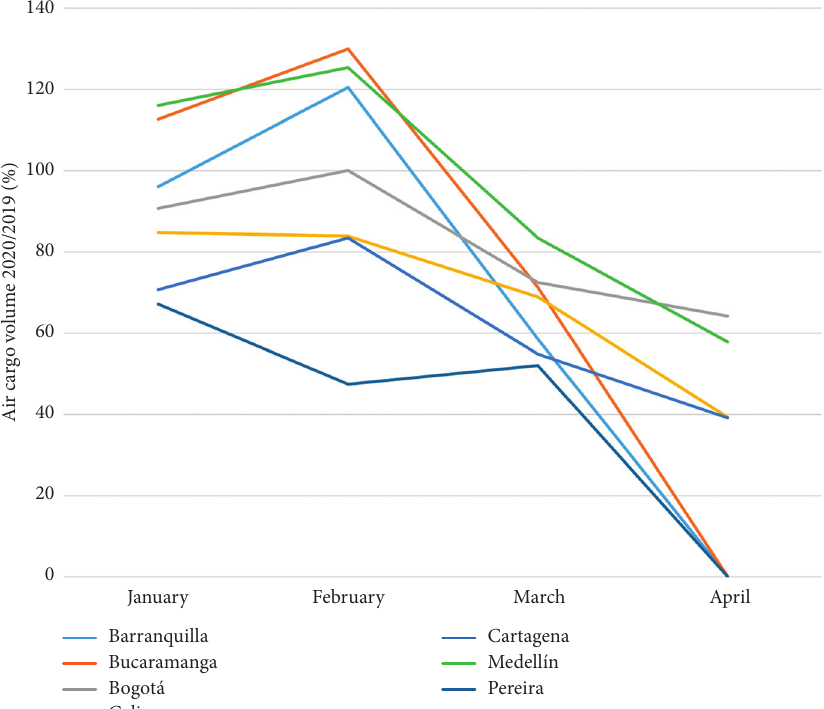
Figure 4: Comparison of air cargo volumes in Colombia considering January to April of 2019 and 2020.